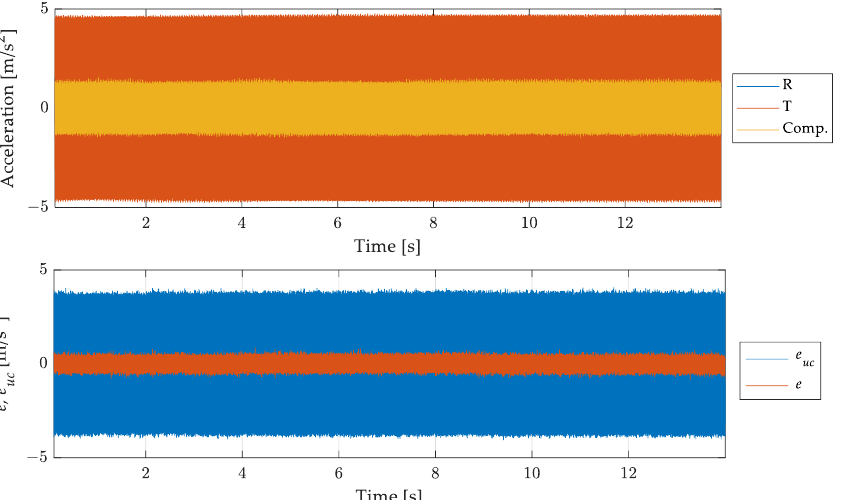
Figure 12. Comparison of the measurand with the (uncompensated) scaled instrument indication and the compensated measurement result. Full acquisition time histories ( top ) and errors for uncompensated e uc and compensated result e ( bottom ).